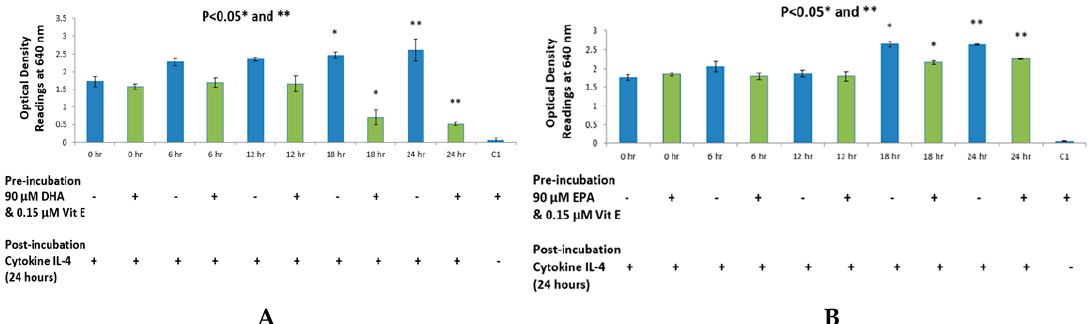
Figure 2. Cont. Figure 3.